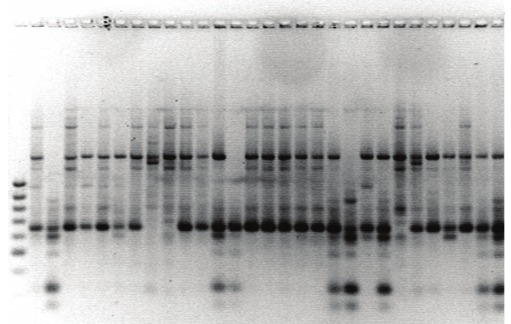
Figure 2: Amplified PCR product using OPC-05 primer.